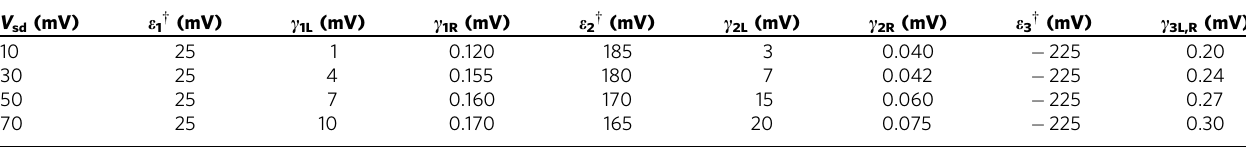
Table 1 | The fitting parameters used to model the experimental